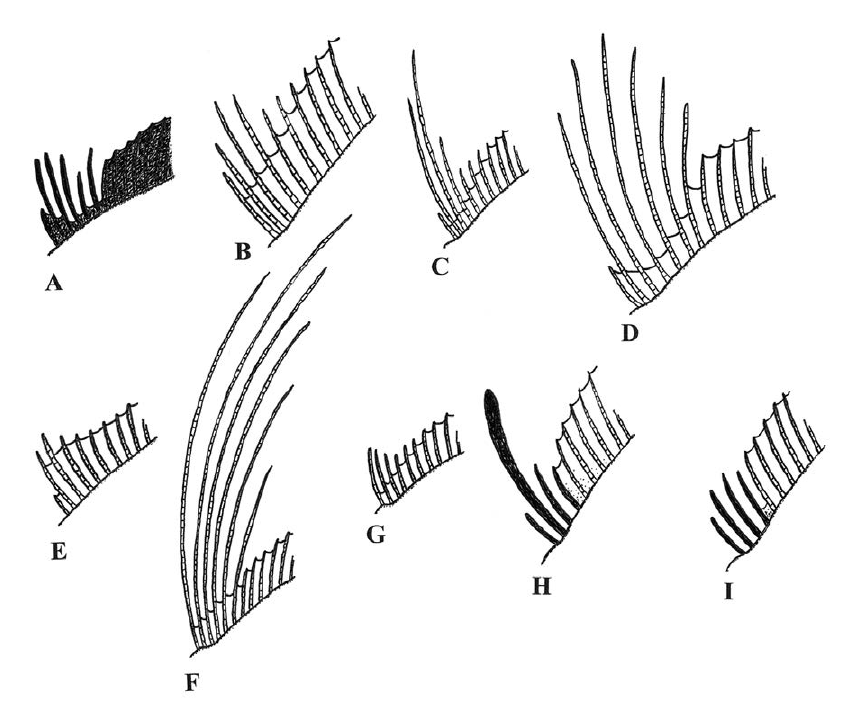
Fig. 4. – Dorsal-fin filaments and anterior dorsal-fin coloration of species of Arnoglossus with several elongate and filamentous rays on anterior dorsal fin, eastern Atlantic, Mediterranean and Indian Ocean. A, A. nigrofilamentosus n. sp. B, A. capensis . C, A. elongatus . D, A. imperialis (male). E, A. imperialis (female). F, A. macrolophus (male). G, A. macrolophus (female). H, A. thori (male). I, A. thori